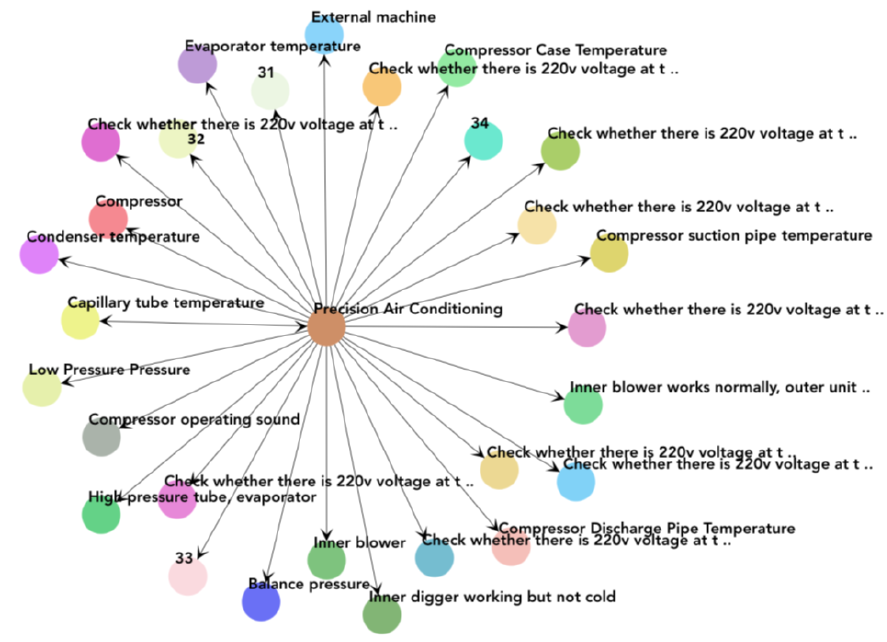
Figure 8. The Search of Precision Air Conditioning from Knowledge